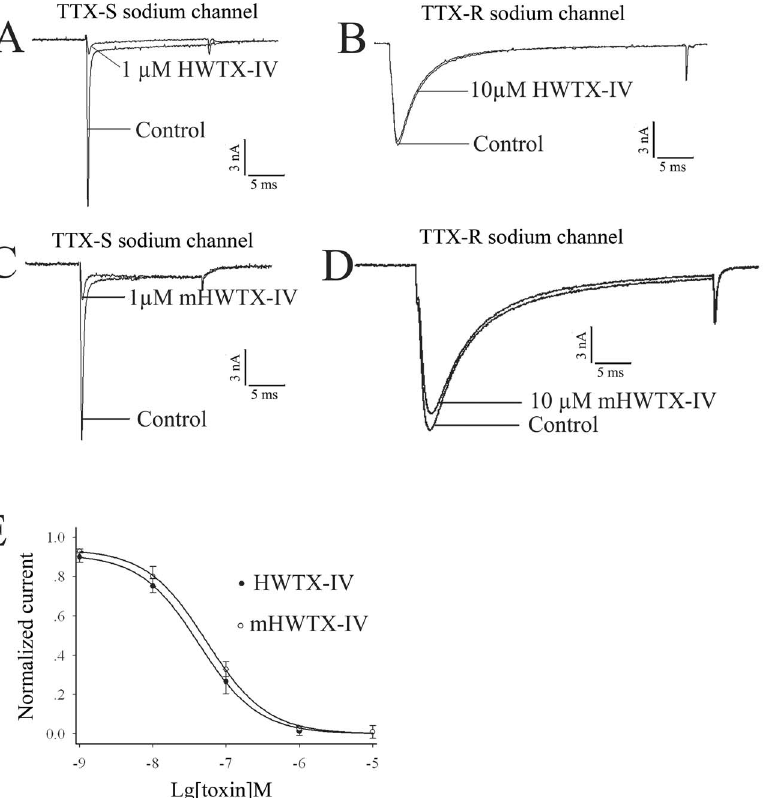
Figure 5. Effects of HWTX-IV and mHWTX-IV on sodium channel in rat DRG neurons. All current traces were evoked by a 50-ms step depolarization to 2 10 mV from a holding potential of 2 80 mV at every second. The currents of TTX-S were significantly reduced by 1- m M HWTX-IV (A) and 1- m M mHWTX-IV (C); 10- m M HWTX-IV (B) and 10- m M mHWTX-IV (D) had no effect on TTX-R sodium currents. (E) shows the concentration dependent inhibition of TTX-S sodium currents on DRG neurons by HWTX-IV (B) and mHWTX-IV. Control for each panel means no toxin treatment. Every data point (mean 6 S.E) was obtained from five separate experimental cells.